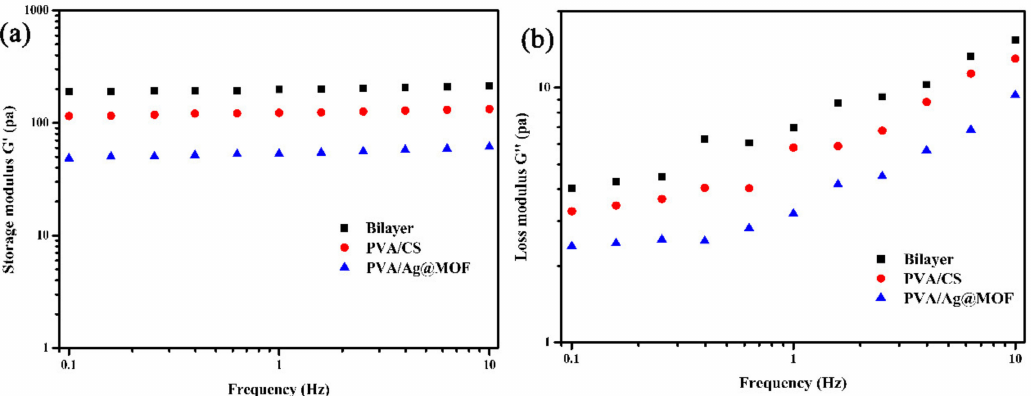
Figure 4. Frequency of ( a ) storage modulus (G (cid:48) ) and ( b ) loss modulus (G”) of PVA/CS (outer hydrogel), PVA/Ag@MOF (inner hydrogel), and Bilayer